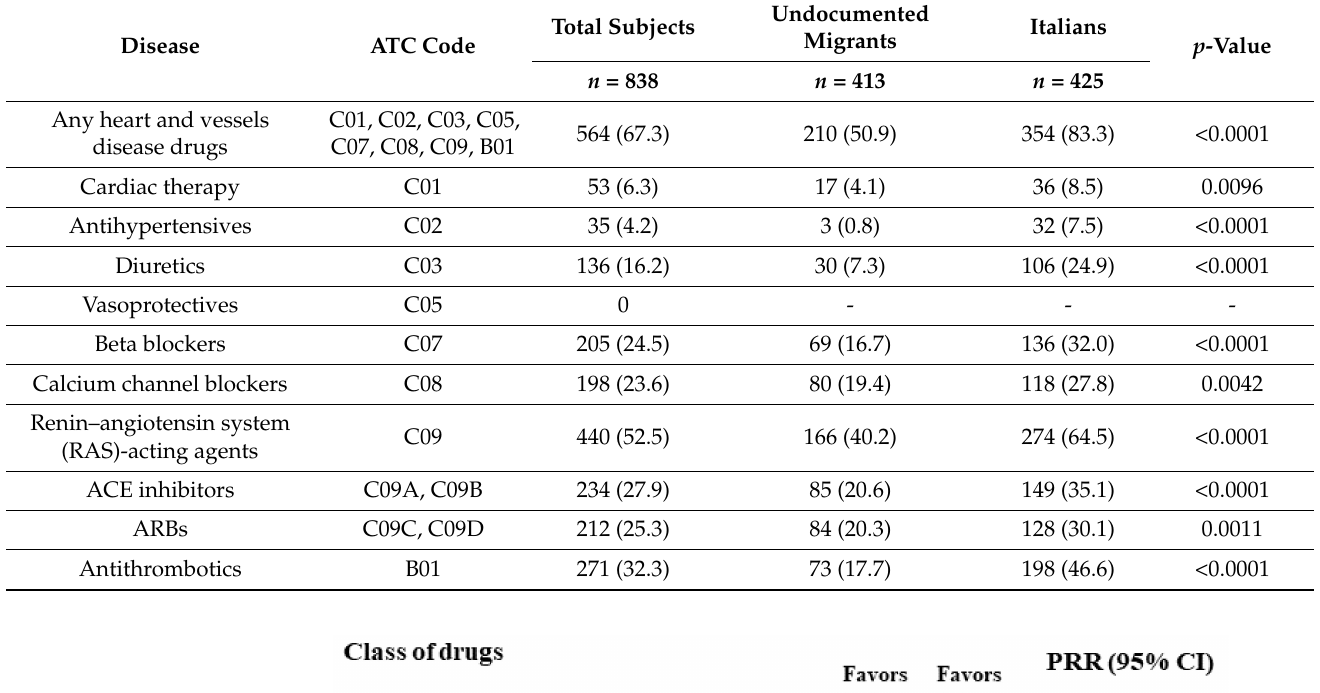
Table 3. CV drugs used for undocumented migrants and Italians with T2DM.